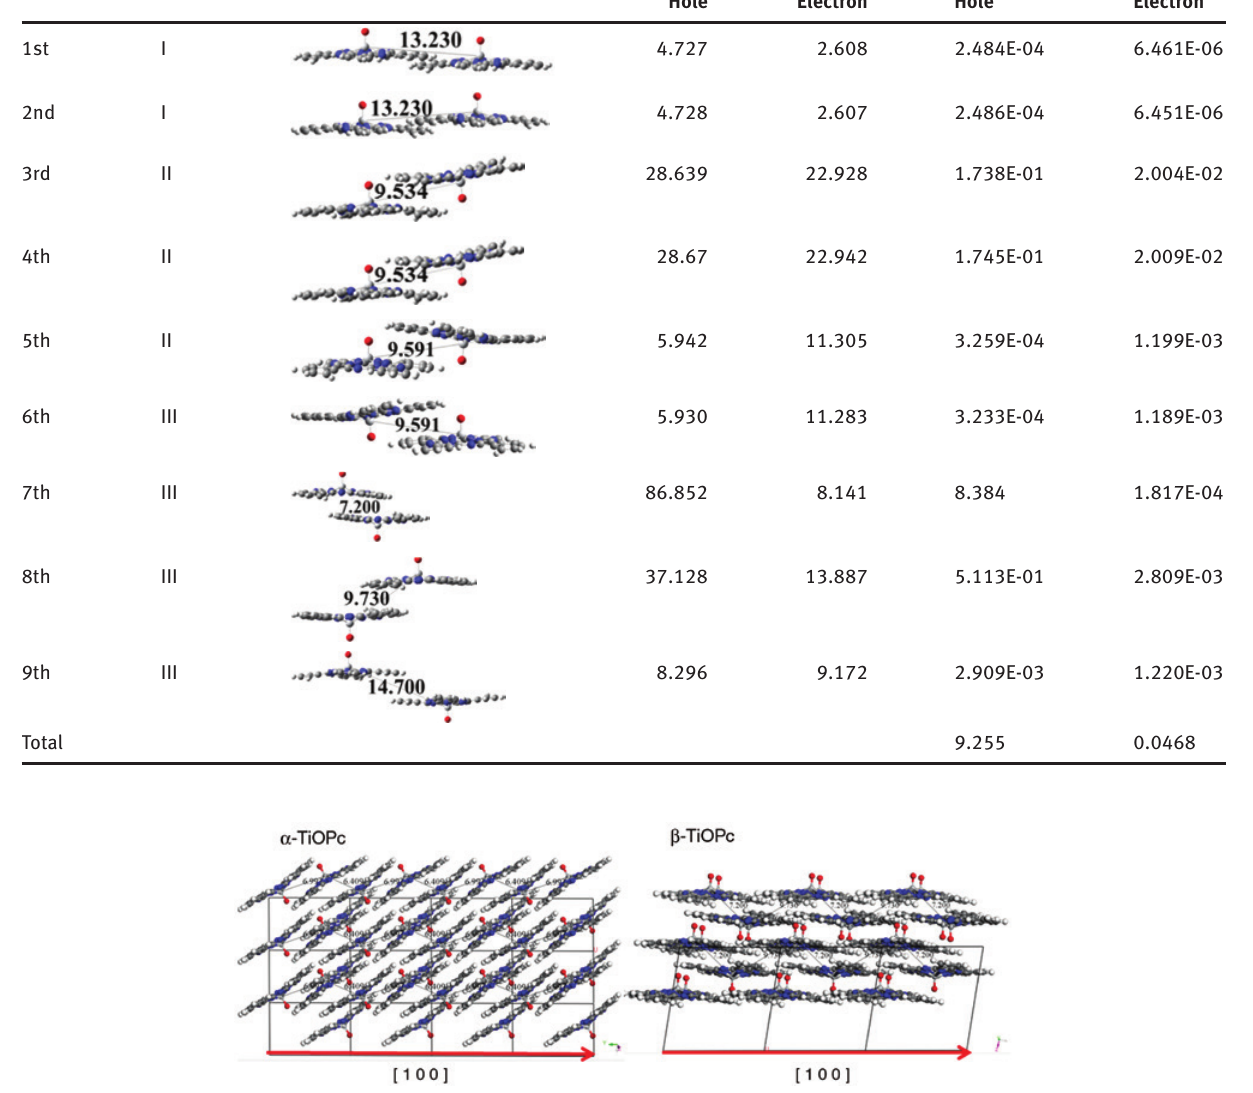
Figure 9: The optimum hole transfer routes in the α -TiOPc and β -TiOPc